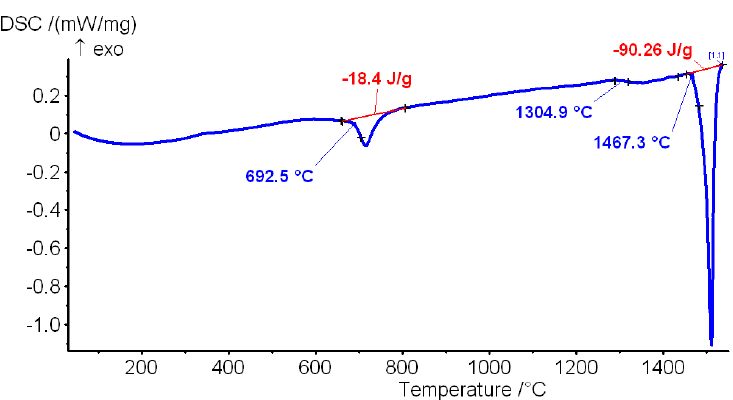
Figure 11. DSC heating curve of carbide coating.